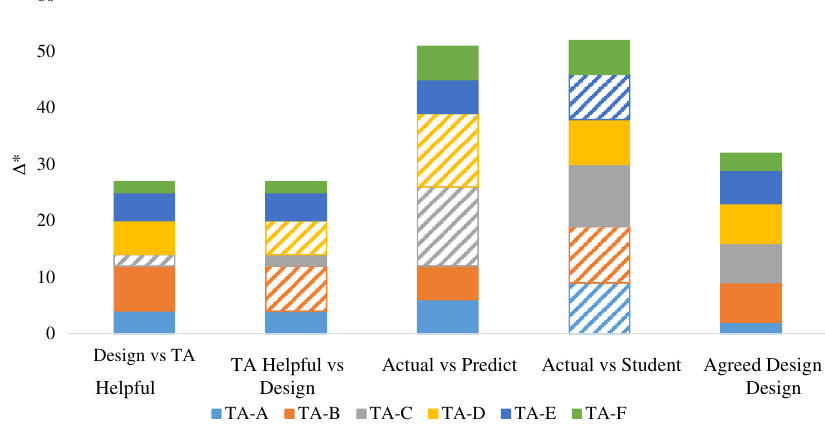
FIG. 9. Most similar comparisons for the Design, Helpful TA, Actual, and Agreed Design groups. A striped section means that this is not the most similar comparison for that